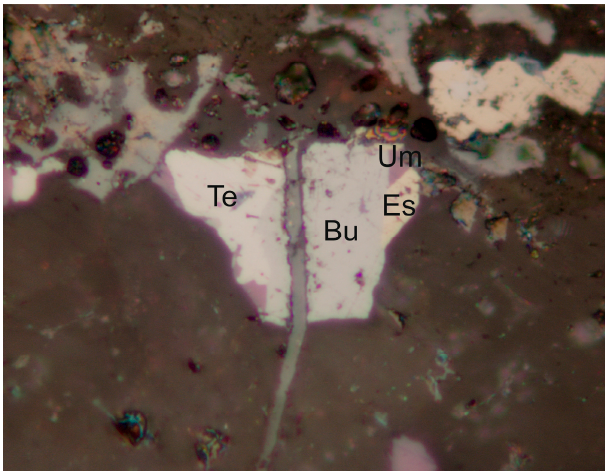
Figure 18. Grey bukovite growing with brownish eskebornite, violet umangite, and grey Zn-hakite. Reflected light, one polarizer. FOV 90 μ m. P ř íbram, a dump of shaft 16. Photo by P. Škácha. The mineral is light grey in reflected light, and weak anisotropy was observed.